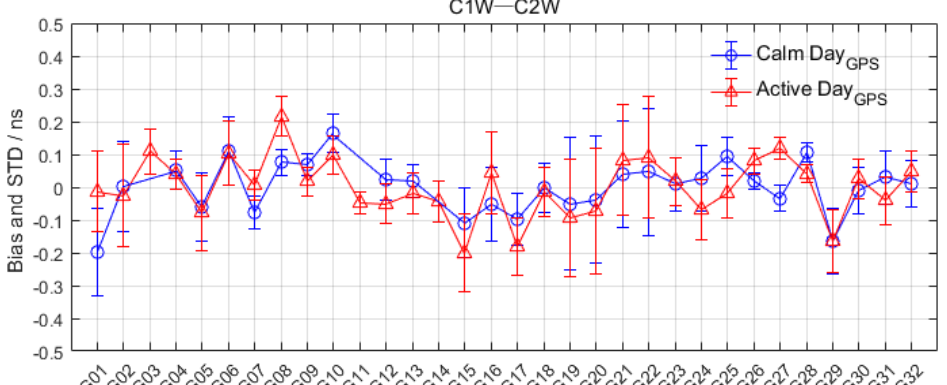
Figure 13. Comparison results between DCB and CODE products of GPS satellite.